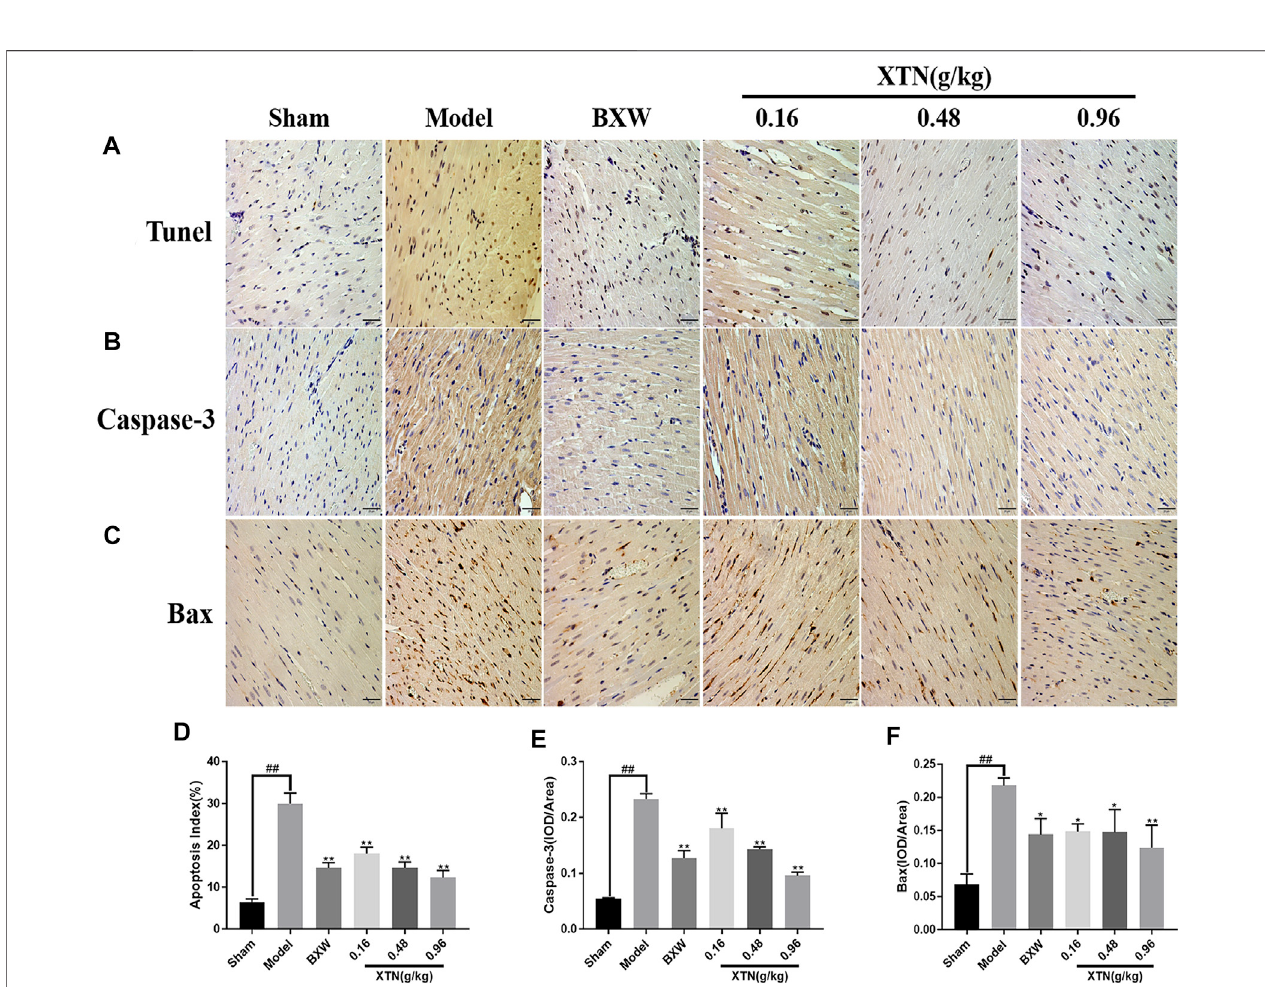
FIGURE7| TunelandImmunohistochemical stainingshowingtheeffects ofXTNonapoptosis inAMIrats( × 400). (A) and (D) Effect ofXTNonapoptosis index. (B) and (E) EffectofXTNonCaspase-3protein. (C) and (F) EffectofXTNonBaxprotein.Datarepresentmean ± SDofthreeormoreindependentexperiment. ## p < 0.01vs. normal group; * p < 0.05, ** p < 0.01 vs. model group.